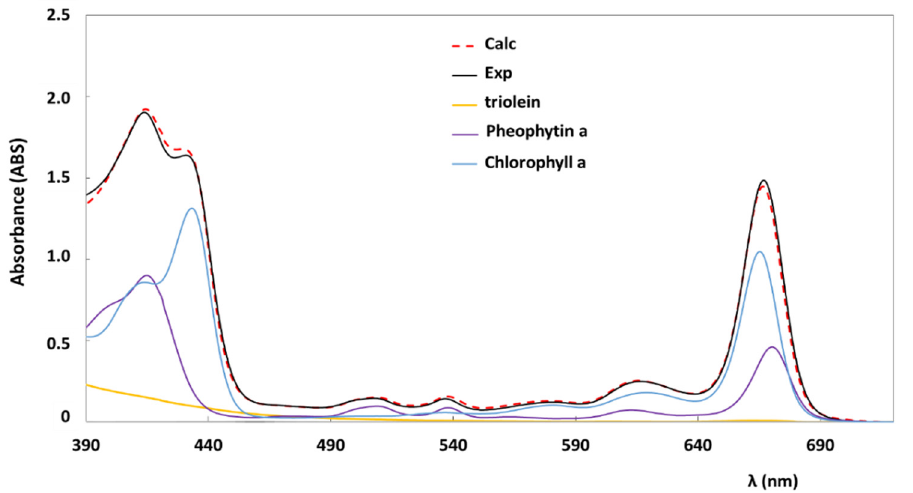
Figure 5. Experimental (Exp) and theoretical (Calc) UV-vis absorption spectra of the test sample (‘CA_20.5 ′ ) at time = 123 ′ during the pheophytinization process (see Figure 4). Single pigments’ spectra used in the deconvolution are also reported, namely chlorophyll a and pheophytin a. Triolein spectral contribution is also shown. Optical path was 0.5 cm. The value of R 2 of the deconvolution was 0.997.